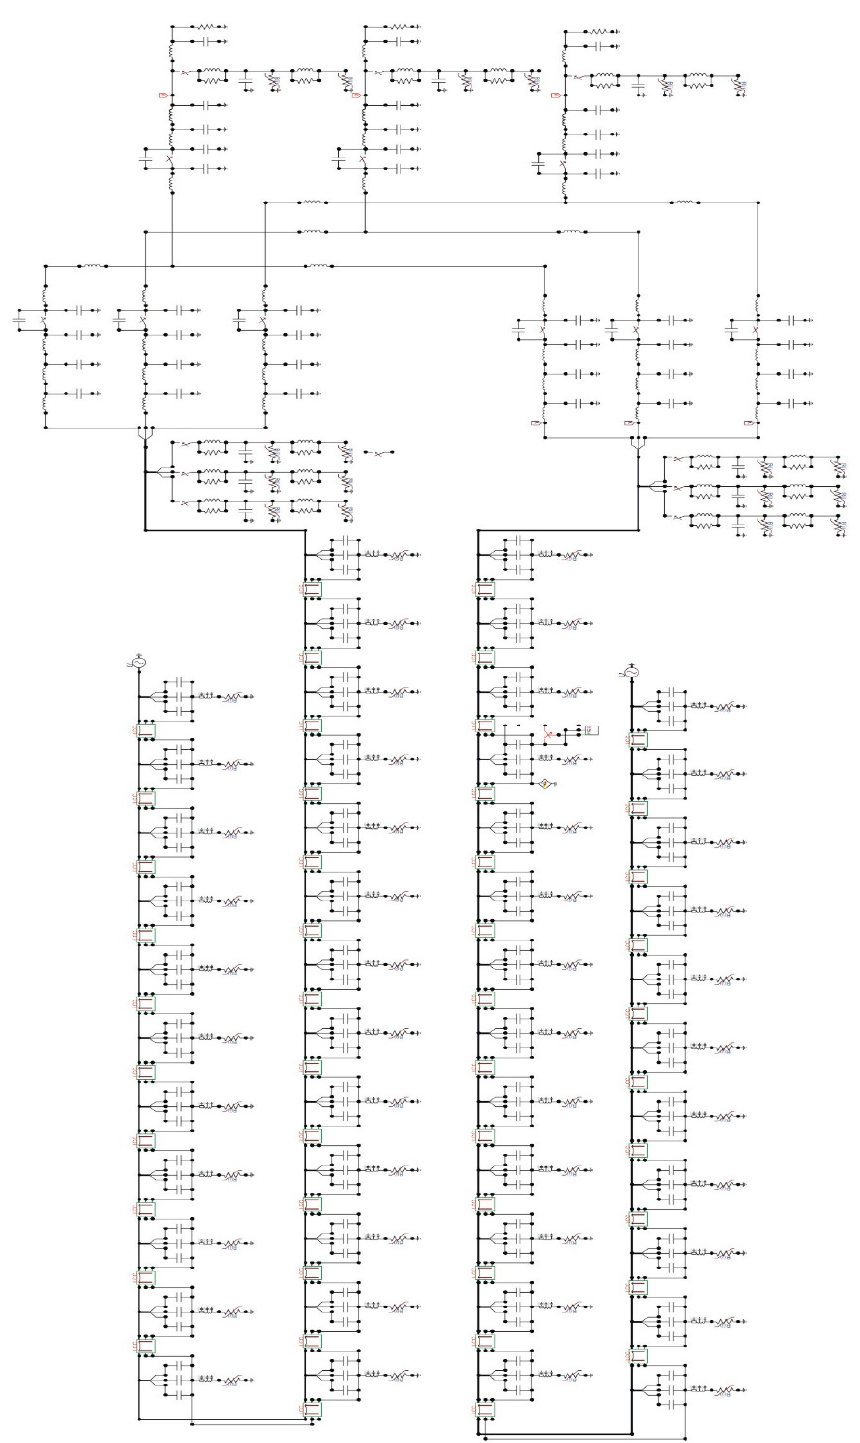
Figure 4. Model prepared in electromagnetic transients program / alternative transients program (EMTP / ATP) of the part of the electrical network presented in Figure 2 used in simulations of lightning overvoltages .